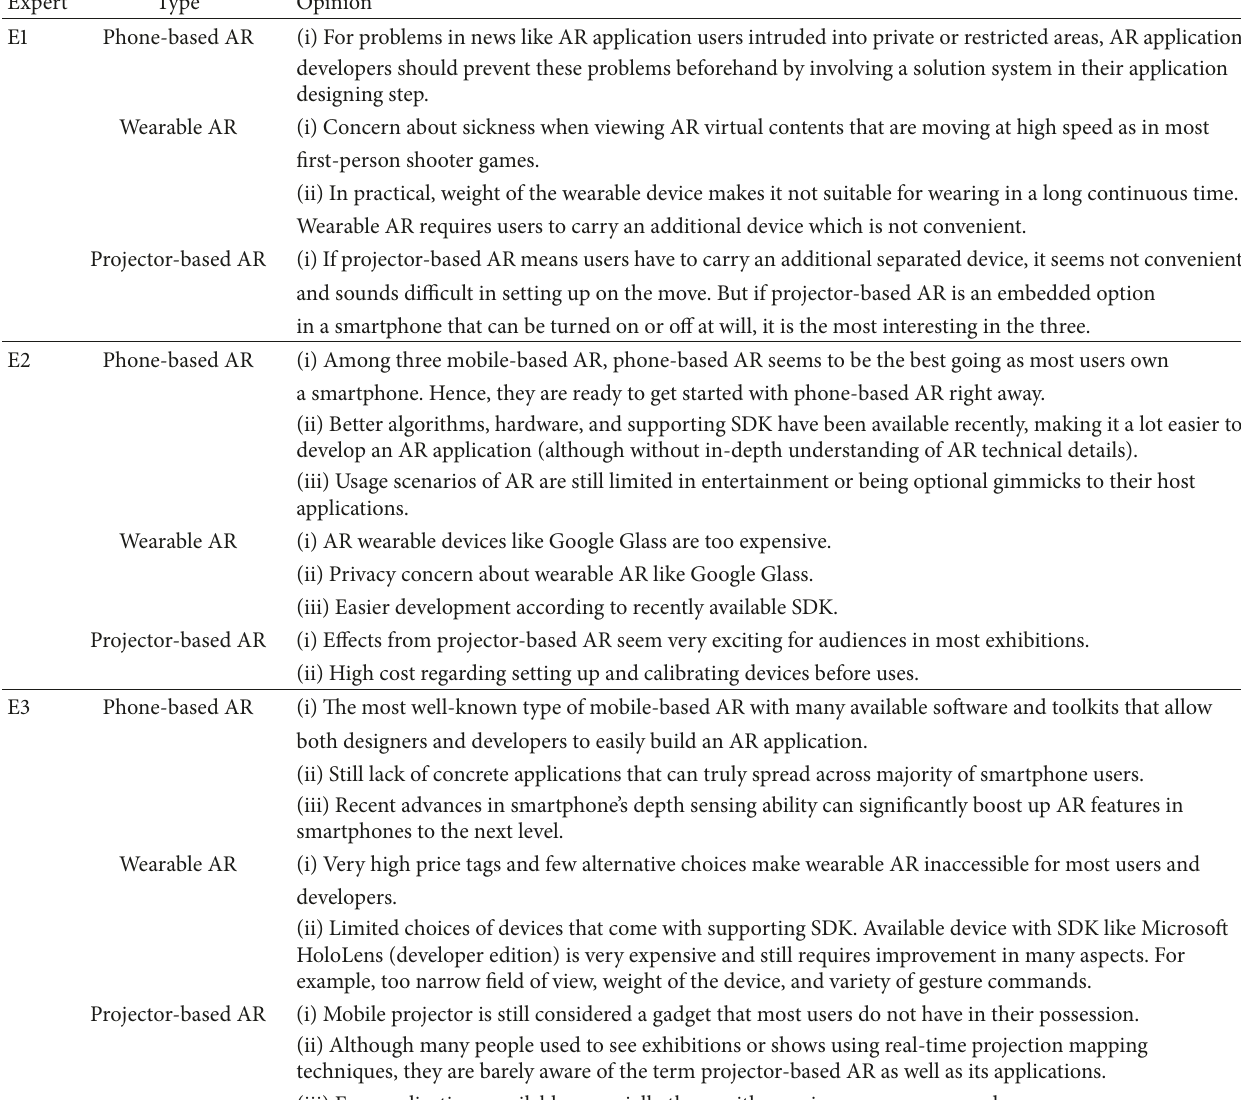
Table 2: Evaluation results from the first step of interview.